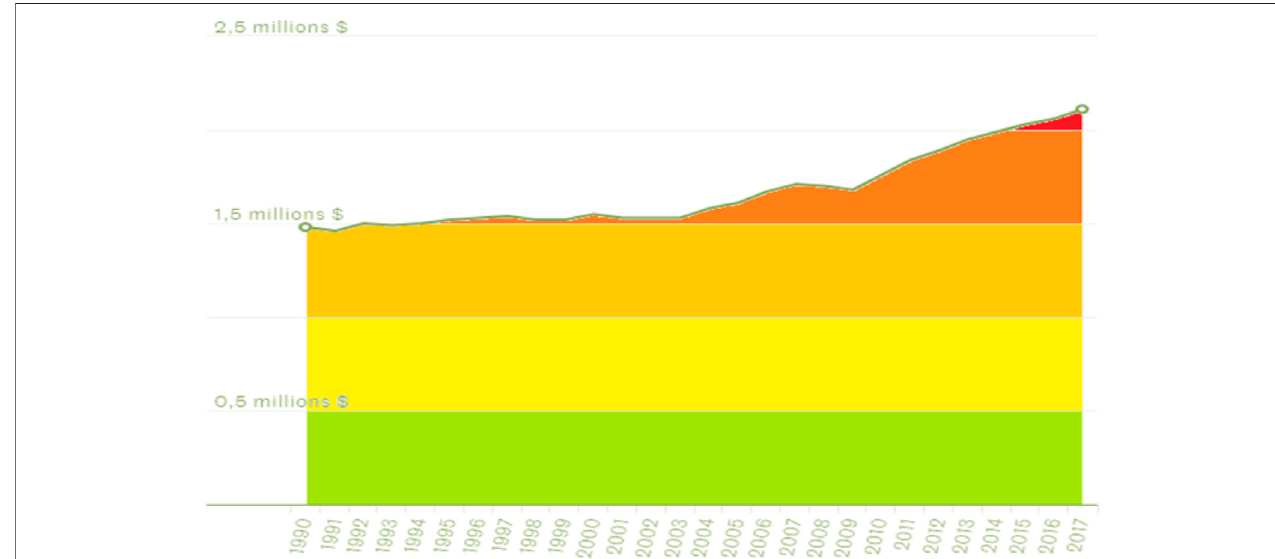
FIGURE 3 | Annual clothing and footwear sales trends. Source: World Development Indicator.